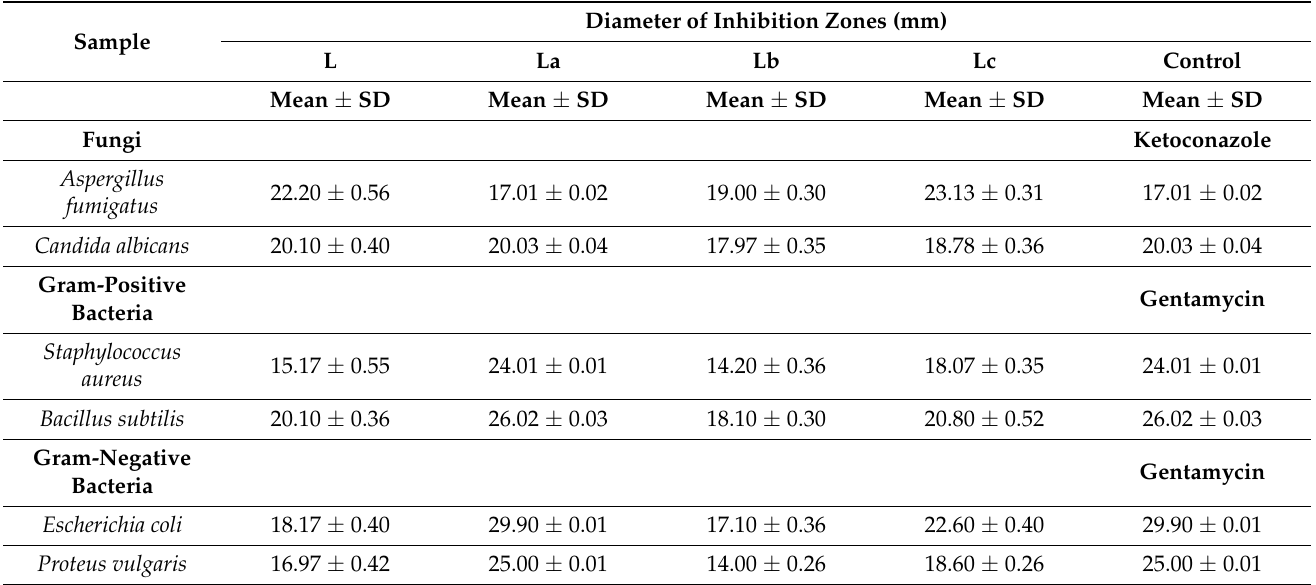
Table 4. Minimum inhibitory concentration in mm ± SD of Schiff base compound and its complexes.